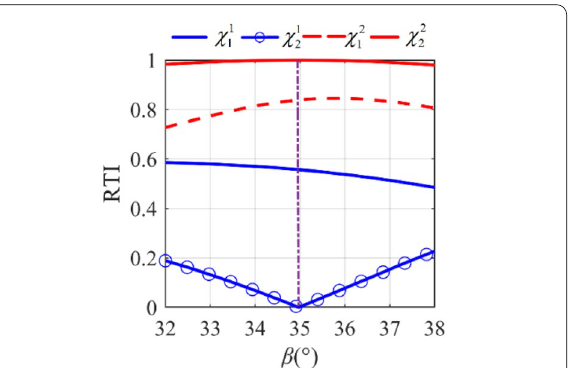
Figure 12 RTI near the transmission